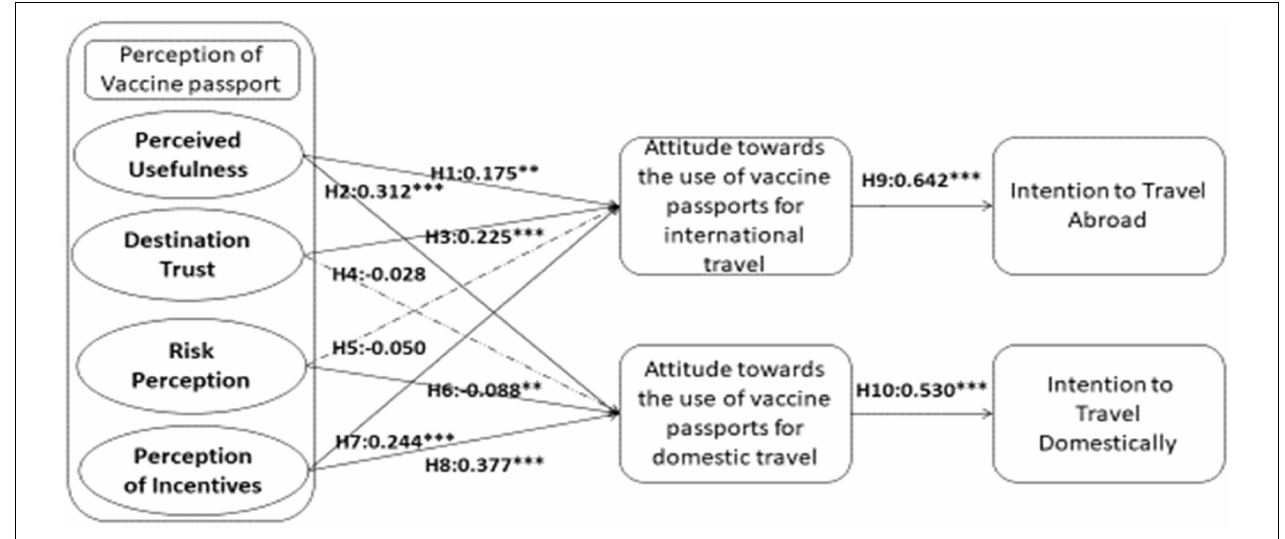
FIGURE 1 | Results of hypotheses tests. ** P < 0.05 and *** P < 0.01.